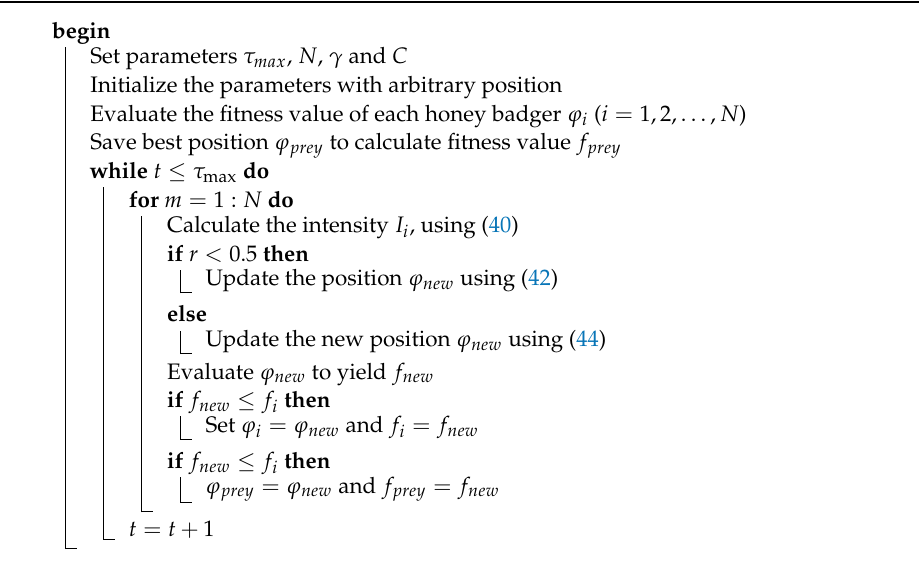
Algorithm 1: Pseudo-code for implementing HBA for a time-delayed hybrid